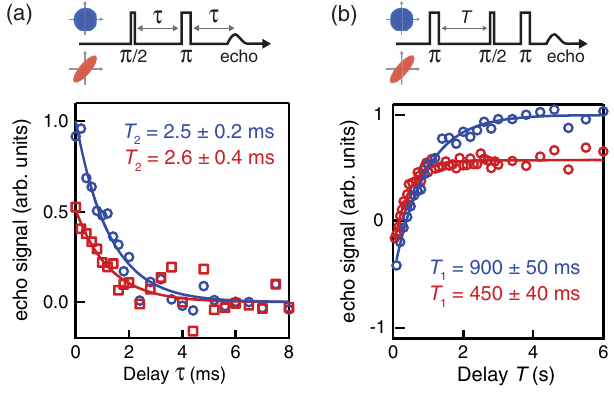
FIG. 6. Influence of squeezing on the spin coherence times. (a) Coherence time T 2 measured with a Hahn echo sequence for SQZ off (blue circles) and on (red squares). Contrary to the experiments in Fig. 5, SQZ is now switched on or off for the entire experimental sequence. The integrated echo signal is plotted as a function of the delay τ between the π = 2 and π ¼ 2 . 5 (cid:3) 0 . 2 ms pulses. Exponential fits (solid lines) yield T 2 ; off ¼ 2 . 6 (cid:3) 0 . 4 ms. (b) Energy relaxation time T and T 2 1 with ; on SQZ on (blue circles) and off (red circles). Exponential fits (solid lines) yield T 1 ¼ 900 (cid:3) 50 ms with SQZ off and T 1 ¼ 450 (cid:3) 40 ms with SQZ off. Both T 1 and T 2 curves [(a) and (b)] have their amplitude reduced by ≈ 0 . 5 with SQZ on, indicating reduced spin polarization in the steady state when the SQZ is continuously switched